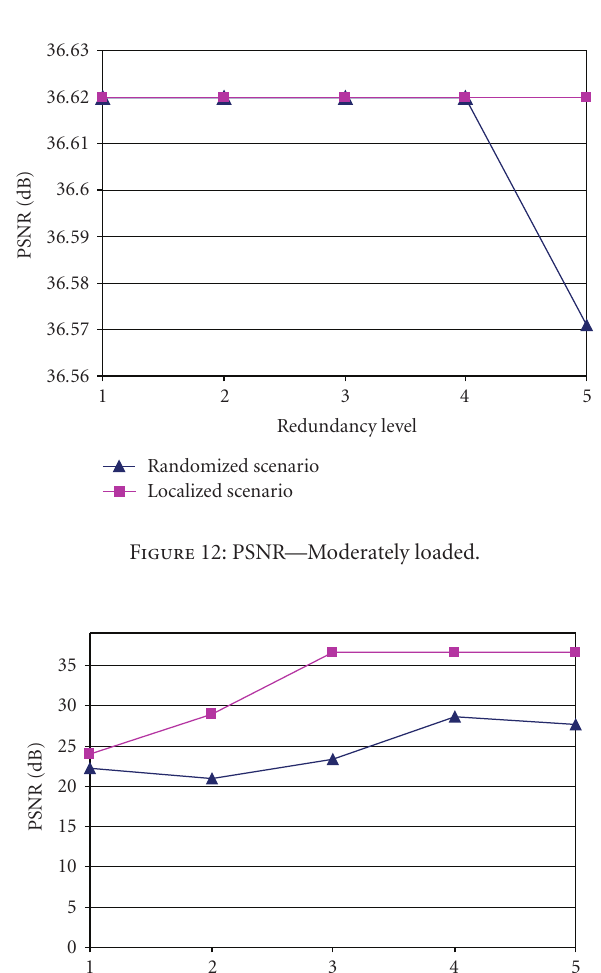
Figure 11: Avg. E2E Delay—Heavily loaded.